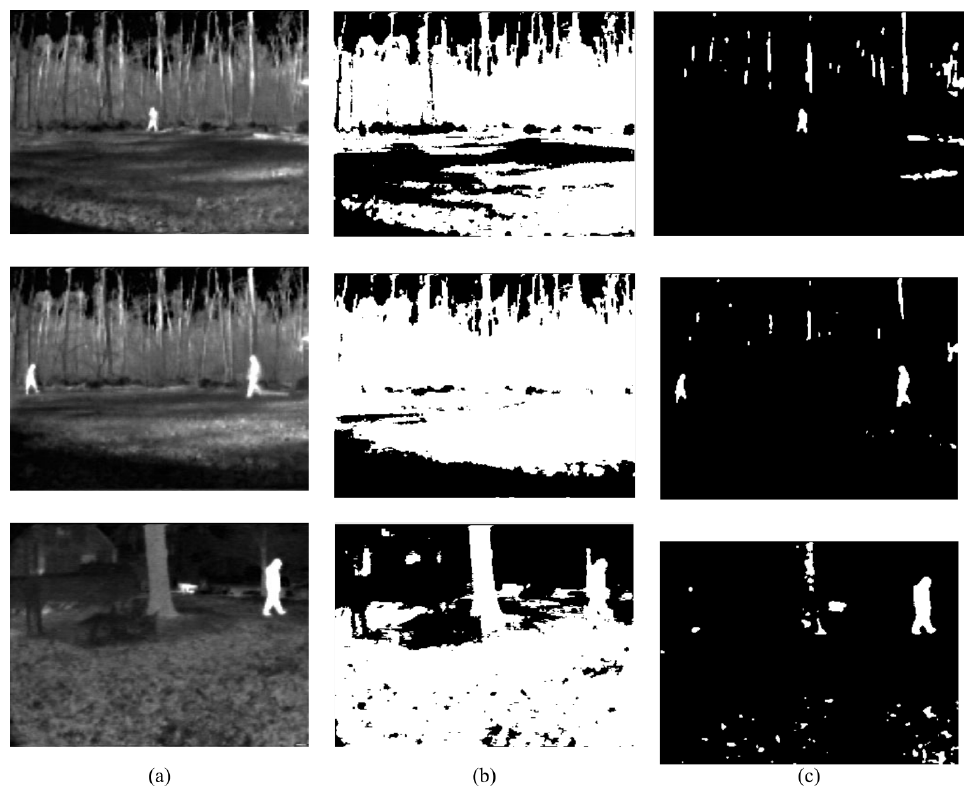
Figure 6. Comparison of outputs using MCET and the proposed method on images from the Terravic Thermal database. ( a ) Original image; ( b ) minimum cross entropy; ( c ) proposed method.